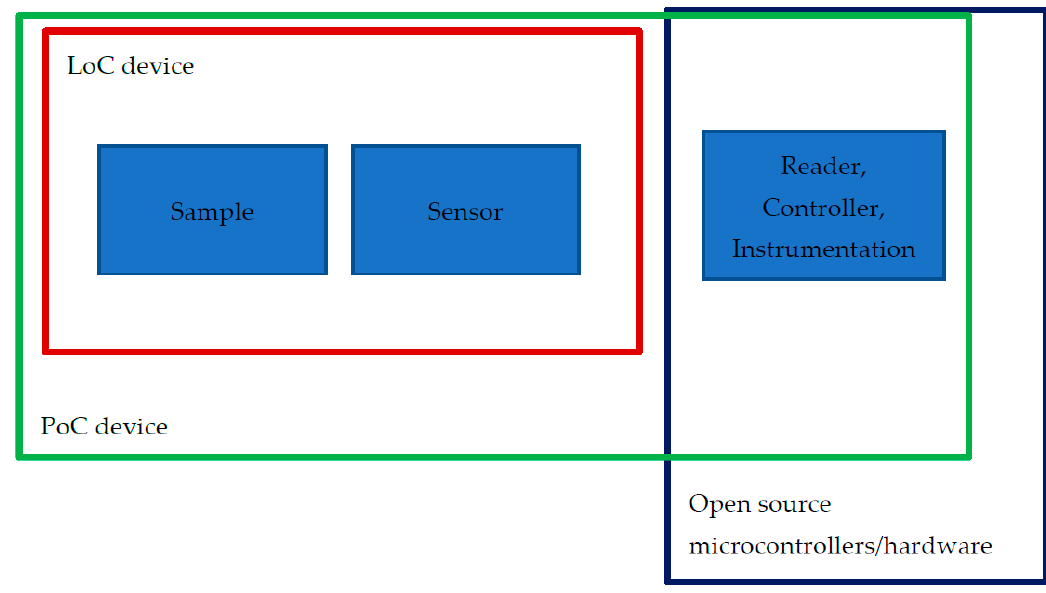
Figure 1. The potential role of open source microcontrollers in the PoC devices.